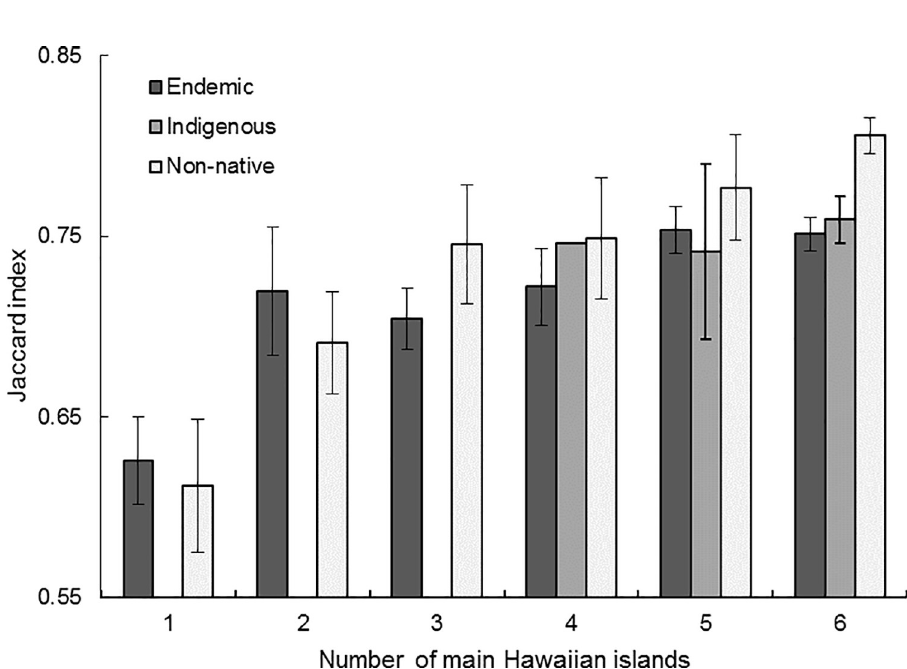
Fig 5. Species specialization by number of main Hawaiian Islands. Plant species ranked as generalists (higher Jaccard index values) occur on more Hawaiian Islands according to the flora, supporting the hypothesis that habitat generalists are more likely to occur on multiple islands because they can persist on diverse substrate types ( p < 0.001; Table 5). Mean values and standard errors are reported.